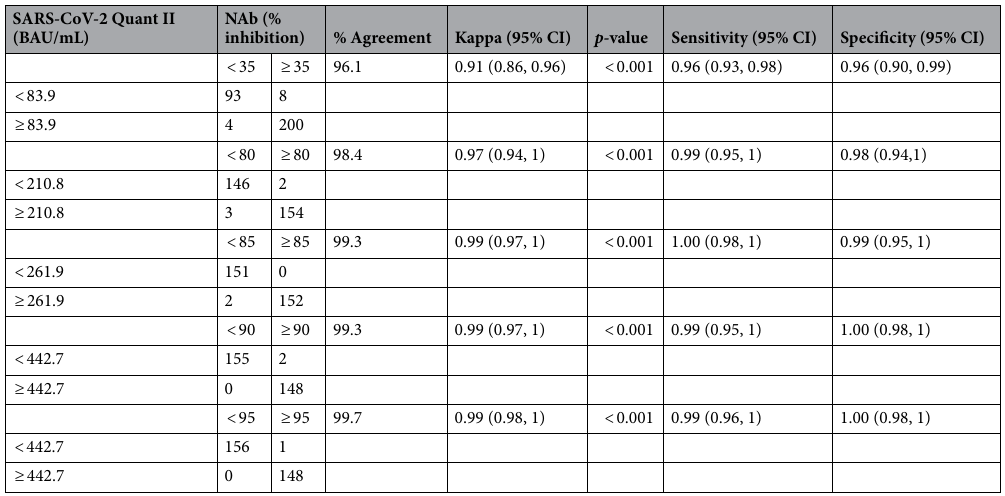
Table 1. The optimal cut-off value of SARS-CoV-2 Quant II using the SARS-CoV-2 NeutraLISA as a reference standard.